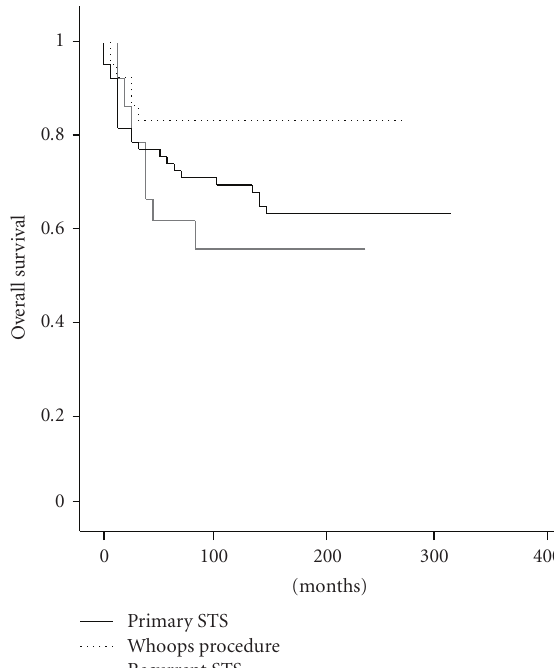
Figure 4: Kaplan-Meier graph showing overall survival comparing the three